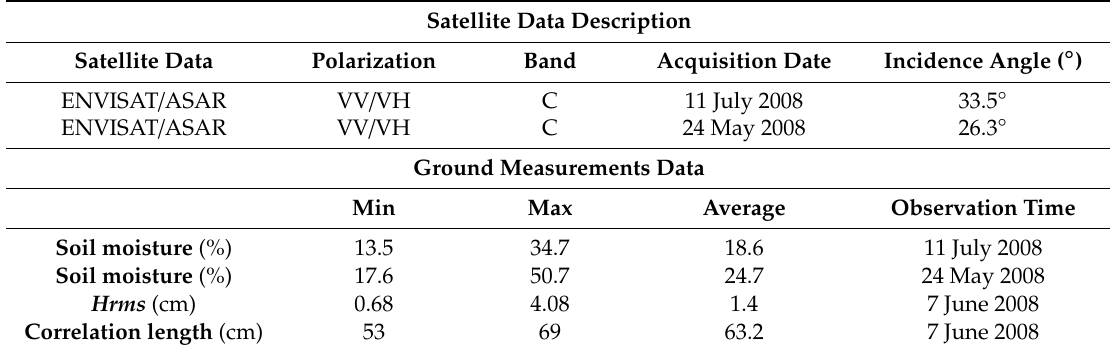
Table 2. ASAR images and simultaneous ground-based measurement